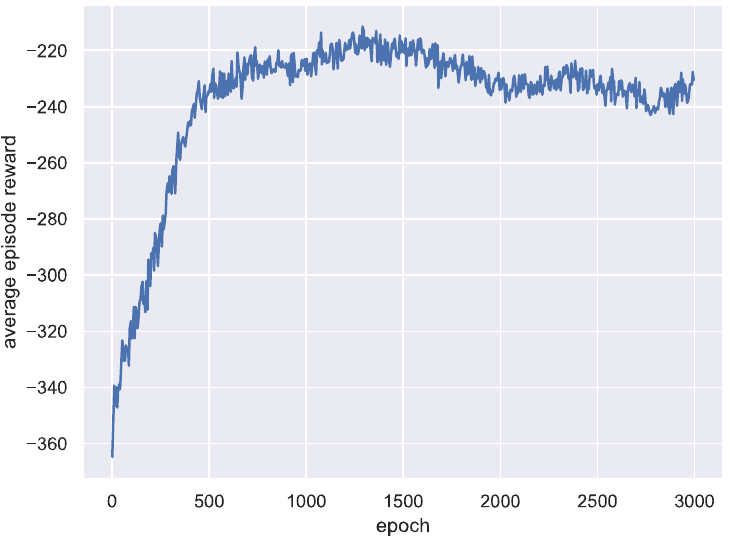
Figure 3. Average episode reward on all test instances at each training epoch.